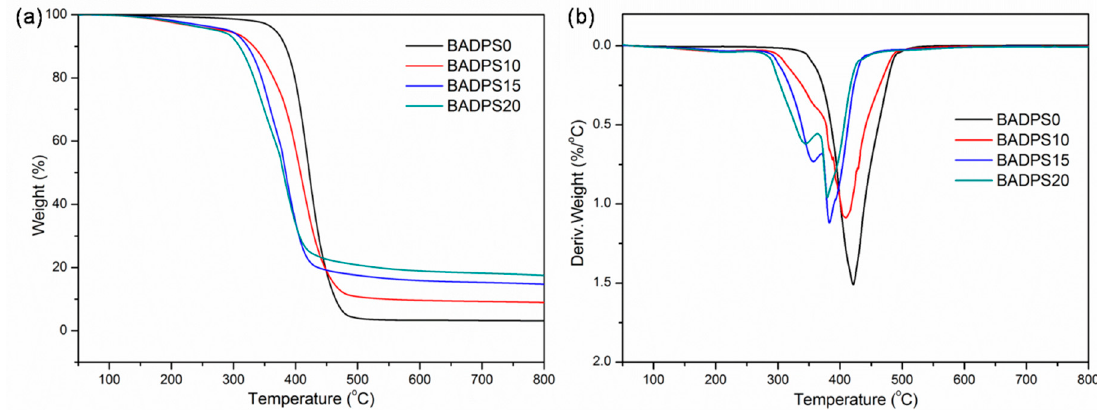
Figure 4. ( a ) TG and ( b ) DTG curves of the different UPRs in an N 2 atmosphere.